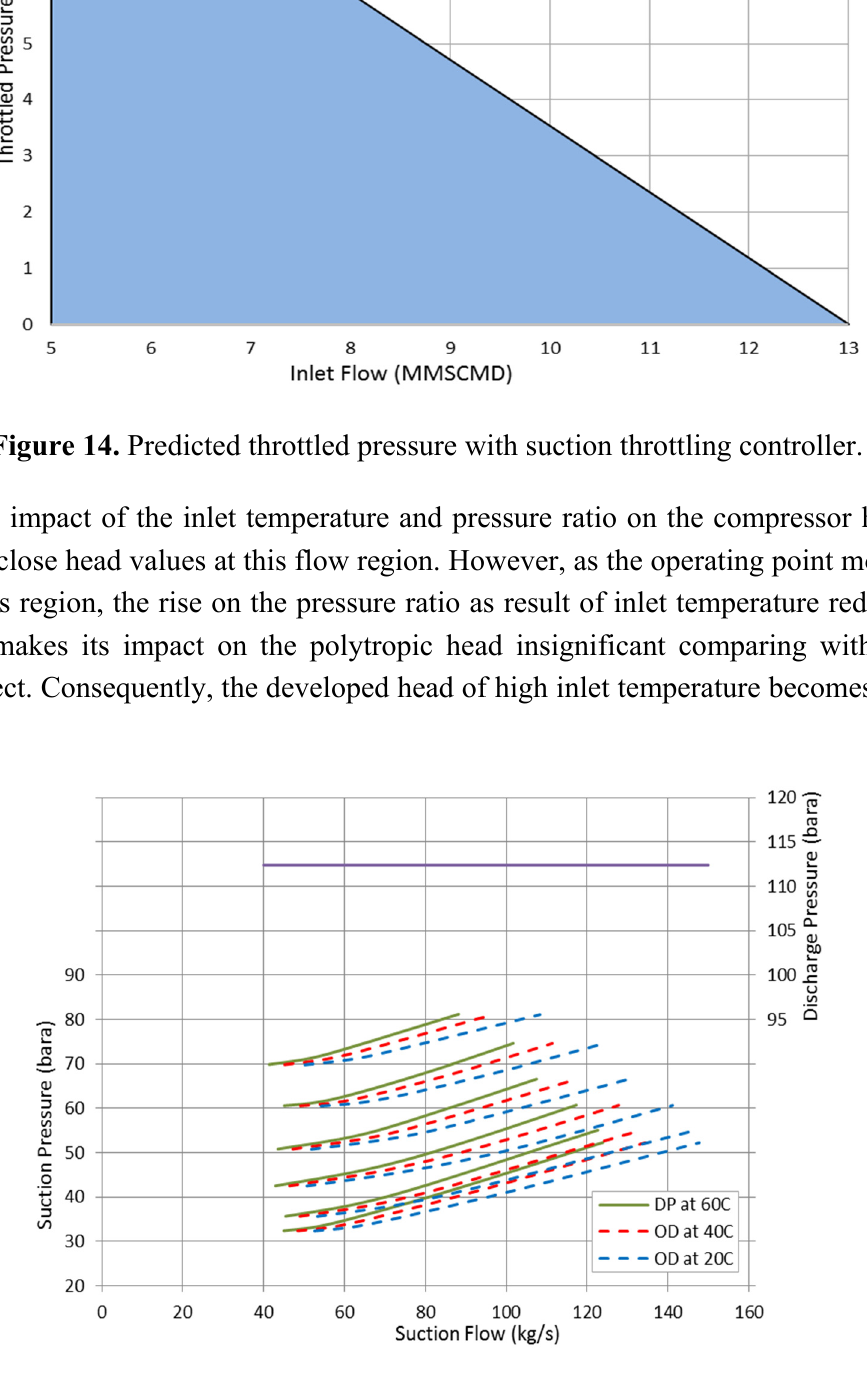
Figure 15. Prediction of suction flow and rotational speed at various suction pressures to maintain a constant discharge